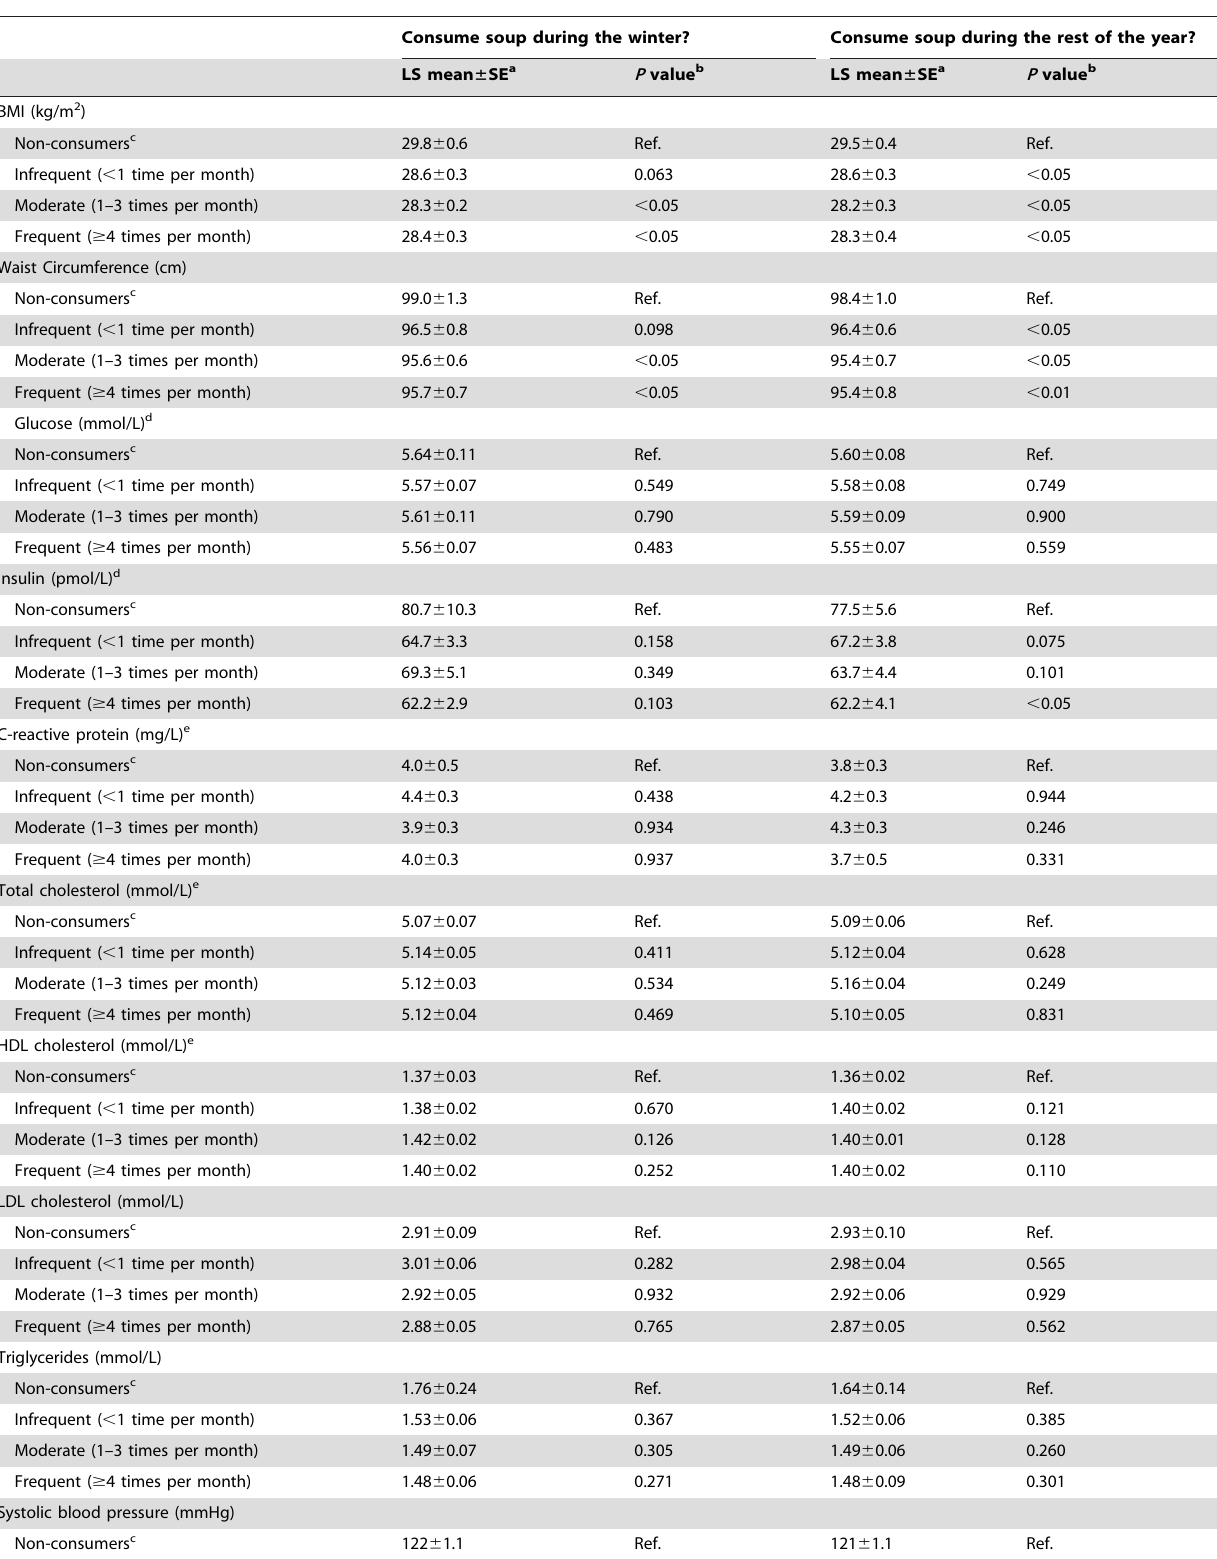
Table 4. Adjusted least square mean of body mass index, biomarkers of metabolic syndrome by frequency of soup consumption: NHANES